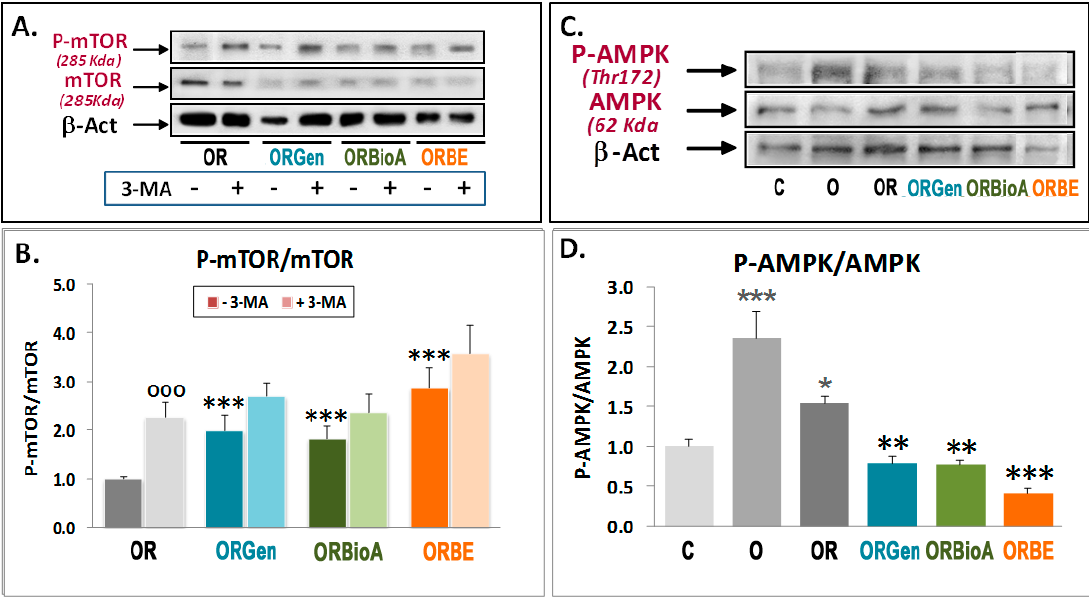
Figure 4. E ff ects of OGDR, phytoestrogens, and 3-MA treatment on mTOR and AMPK phosphorylation. Figure 4. Effects of OGDR, phytoestrogens, and 3-MA treatment on mTOR and AMPK Western blots of mTOR, 2448 SerP-mTOR ( A , B ), and 172 Thr-P-AMPK ( C , D ) were performed in extracts phosphorylation. Western blots of mTOR, 2448 SerP-mTOR (A–B), and 172 Thr-P-AMPK (C–D) were of cortical neurons exposed to 3 h OGD exposure (O) and 24 h OGDR (OR) in the absence or presence performed in extracts of cortical neurons exposed to 3 h OGD exposure (O) and 24 h OGDR (OR) in of 5 mM 3-MA ( A , B ) or under OR conditions in the absence or presence of 1 µ M Genistein (Gen), the absence or presence of 5 mM 3-MA ( A – B ) or under OR conditions in the absence or presence of 1 μ M Genistein (Gen), BiocaninA (BioA), and 17- β -estradiol (BE)). Upper panels ( A and C ) show BiocaninA (BioA), and 17- β -estradiol (BE)). Upper panels ( A , C ) show representative Western blots. Lower panels ( B , D ) represent the quantitative analysis of indicated ratios and are mean ± SEM of three representative Western blots. Lower panels ( B and D ) represent the quantitative analysis of indicated experiments, each one performed in duplicate. Statistics comparing the e ff ect of 5 mM 3-MA in each ratios and are mean ± SEM of three experiments, each one performed in duplicate. Statistics condition versus respective conditions in the absence of this compound ( ooo ) panel ( B ), the e ff ect of O comparing the effect of 5 mM 3-MA in each condition versus respective conditions in the absence of and OR over control C3 (***) panel ( D ), and the e ff ect of phytoestrogens on OR condition without them this compound ( ooo ) (panel B ), the effect of O and OR over control C3 ( *** ) (panel D ), and the effect of (***) panels ( B , D ), at * p < 0.05, ** p < 0.01, and *** p < 0.001 (one-way ANOVA test) are phytoestrogens on OR condition without them (***) (panels B and D ), at * p < 0.05, ** p < 0.01, and *** p < 0.001 (one-way ANOVA test) are shown.